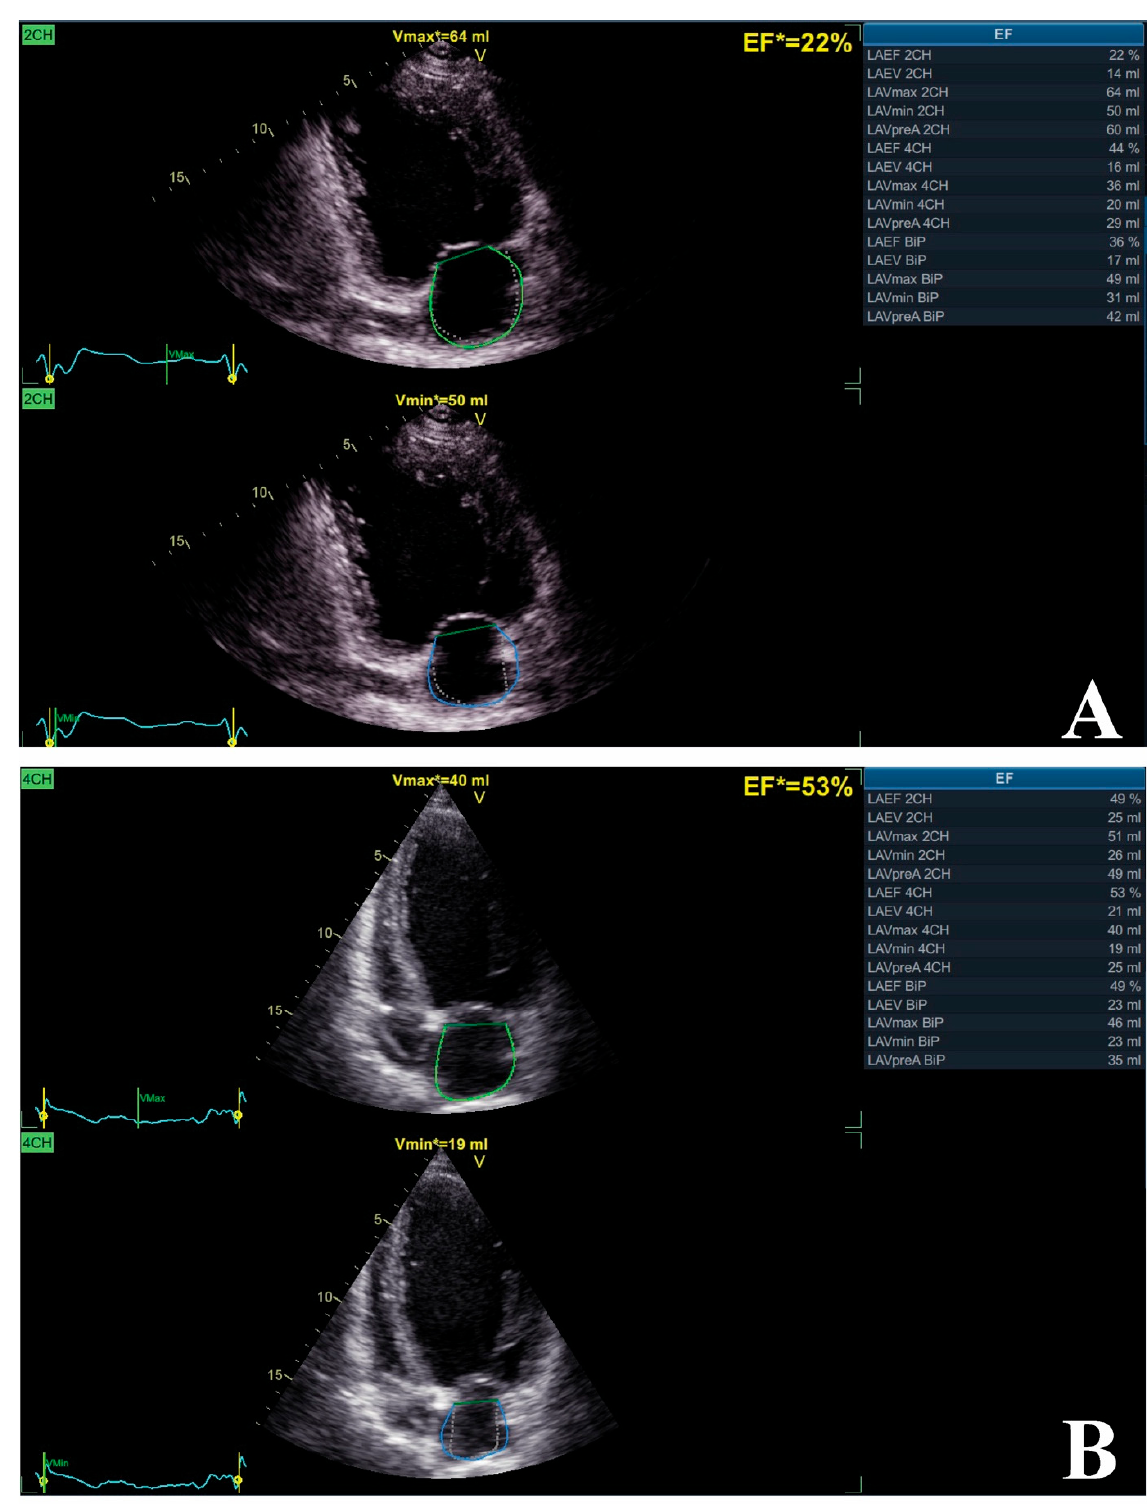
Figure 1. The impact of CRT on LA volumes. Patient with dilated cardiomyopathy, LVEF of 33%, and QRS morphology of LBBB with duration of 153 msec. Echocardiographic evaluation using a General Electric VIVID E95 vendor and EchoPac software package to determine LA biplane volumes (Images from the personal collection of the authors). Initial evaluation showed increased LA volumes ( A ) and, after a 6-month follow-up, significant LA remodeling with reduction in LA volumes can be seen ( B ). Abbreviations: LA, left atrium; LBBB, left bundle branch block; LVEF, left ventricle ejection fraction.